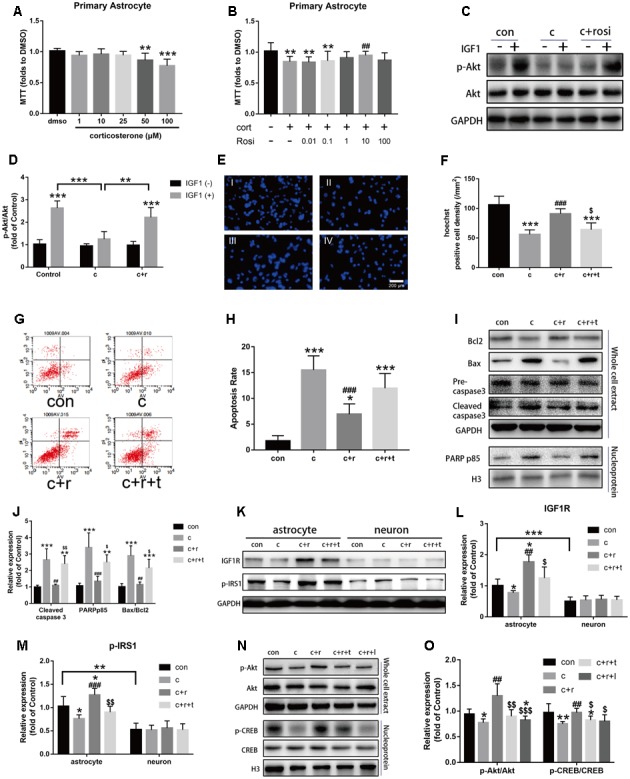
Corticosterone-induced astrocyte apoptosis is relieved by rosiglitazone. (A,B) The vitality of astrocytes exposed to specific concentrations of corticosterone and rosiglitazone were measured by the MTT assay. (C,D) Western blotting analyzed the p-Akt/Akt of three astrocyte groups cultured in DMEM with or without IGF-1. (E,F) Hoechst labeled cells by immunofluorescence and quantified the number of astrocytes. (G,H) Flow cytometry measured the apoptosis of the corticosterone, rosiglitazone, and T0070907 (10 μM) groups. (I,J) The expression of apoptosis-associated proteins Bcl2 and BAX, total and cleaved caspase 3, and PARP were detected by WB. (K–M) The different IGF-1R and p-IRS1 expressions in astrocytes and neurons exposed to corticosterone, rosiglitazone, and T0070907 were detected by WB. (N,O) The ratios of p-Akt in whole-cell extracts and p-CREB in nucleoproteins differed under exposure to corticosterone, rosiglitazone, T0070907 (10 μM), and LY294002 (10 μM). Data are presented as means ± SEMs; n = 4–6 for all groups. ∗p < 0.05 vs. control, ∗∗p < 0.01 vs. control, ∗∗∗p < 0.001 vs. control, #p < 0.05 vs. corticosterone, ##p < 0.01 vs. corticosterone, ###p < 0.001 vs. corticosterone, $p < 0.05 vs. control, $$p < 0.01 vs. control. cort, corticosterone; rosi, rosiglitazone; c+r, corticosterone + rosiglitazone; c+r+t, corticosterone + rosiglitazone+T007090; c+r+l, corticosterone + rosiglitazone+ LY294002.